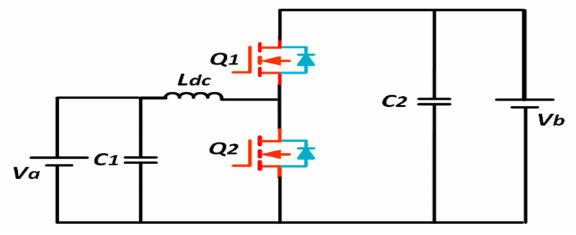
Figure 4. Bidirectional buck–boost converter